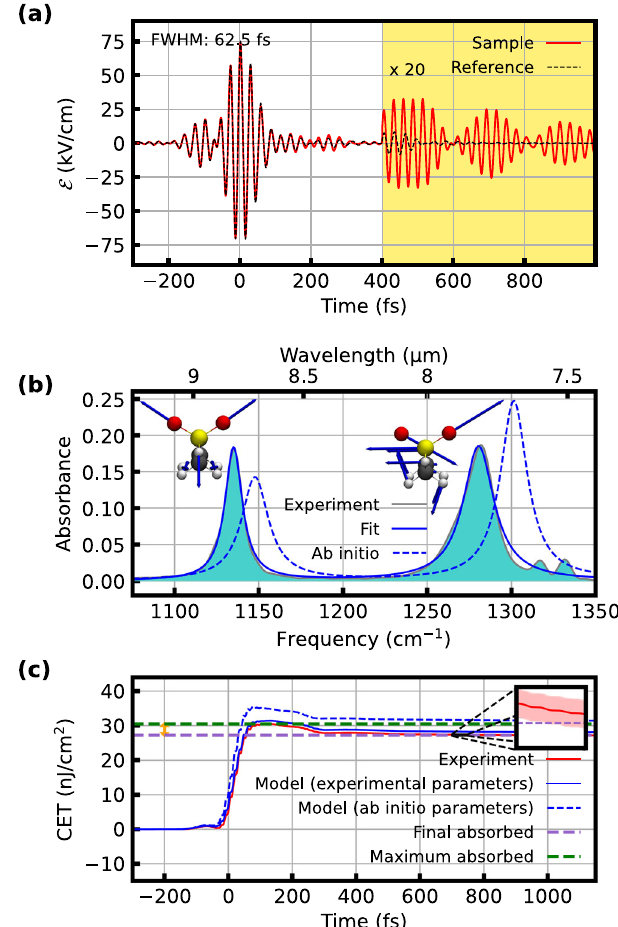
Fig. 2 | Few-cycle excitation (FCE). a Electric fi eld of the compressed excitation pulseaftertransmissionthrougha30- μ mthicklayerofwater(black,dashed)anda solution of 10mg/ml DMSO 2 in water (red). b Absorbance derived from the mea- surementsin a .Themolecularstructuresillustratethecorrespondingdisplacement vectors (blue arrows) of the vibrational modes responsible for the two main absorption bands, the symmetric (left) and asymmetric (right) SO 2 stretching vibrations. Solid blue: Lorentzian fi ts, dashed blue: ab initio calculations (see text). c Coherent energy transfer CET( t ) between the excitation fi eld and the DMSO 2 sample, extracted from the experimental data (solid red line: mean value of three consecutive measurements, each comprising 20 scans, shaded red area: error corridor determined with Gaussian error propagation, see Methods), from mod- eling with the fi tted Lorentzian parameters (solid blue line), and with Lorentzian parametersobtainedabinitio(dashedblueline).Thedashedgreenandpurplelines show the maximum and end level of the CET, respectively. Their difference is the coherentlyemitted energy,whichis 11%of the maximum absorbed energy (orange double